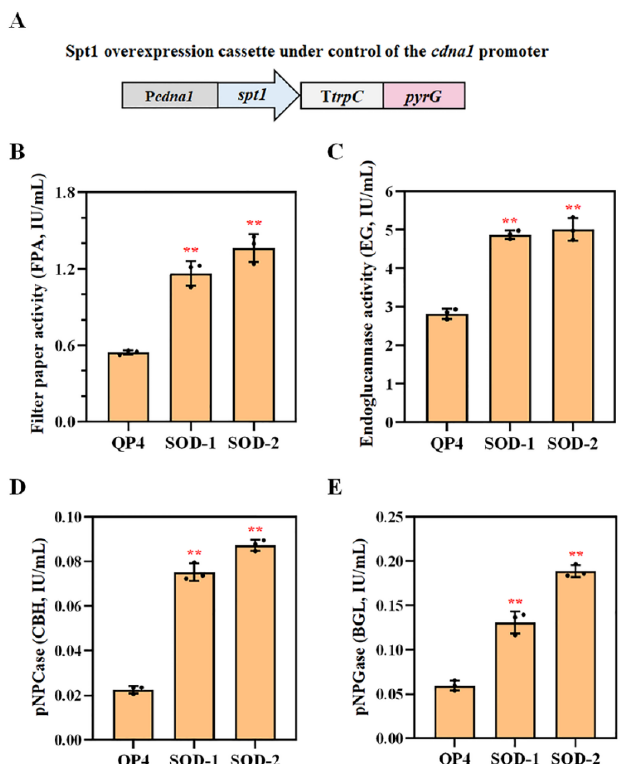
Figure 7. Cellulase production by the strains SOD-1 and SOD-2, using the strong constitutive promoter P cdna1 to drive spt1 overexpression. ( A ) Schematic diagram of the spt1 gene overexpression cassette (6.0 kb) under the control of the strong constitutive promoter P cdna1 . The cassette would be inserted into the genome of T. reesei with multiple copies by random integration. The filter paper activity ( B ), the endoglucanase (EG) activity ( C ), the cellobiohydrolase (CBH) activity ( D ) and the β -glucosidase (BGL) activity ( E ) of the culture supernatant from the spt1 overexpression strains (SOD-1, SOD-2) and the parental strain QM53 were measured on the 7th day of fermentation. The strains were cultured in cellulase-inducing medium containing MCC as the carbon source at 30 °C for 7 days. The values represent the mean of three repeated measurements taken from at least three parallel experiments. The error bars refer to the standard deviations (SD). The difference between the parental strain and the overexpression strains was shown by the analysis of ANOVA, followed by the Turkey test. ** p <